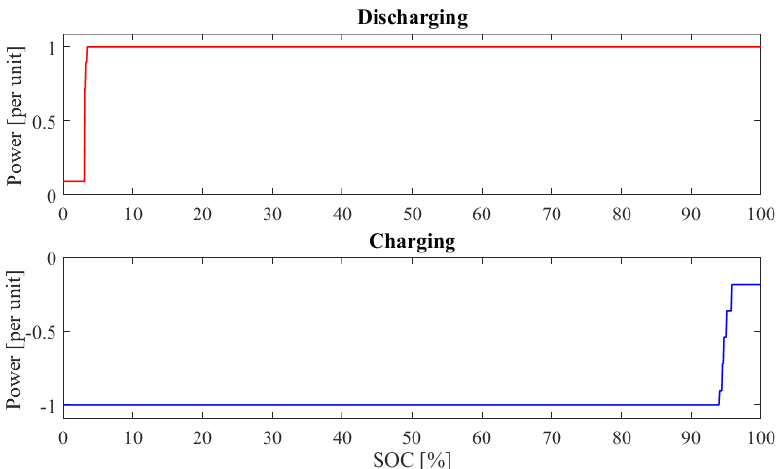
Figure 9. Capability chart as implemented in the model.